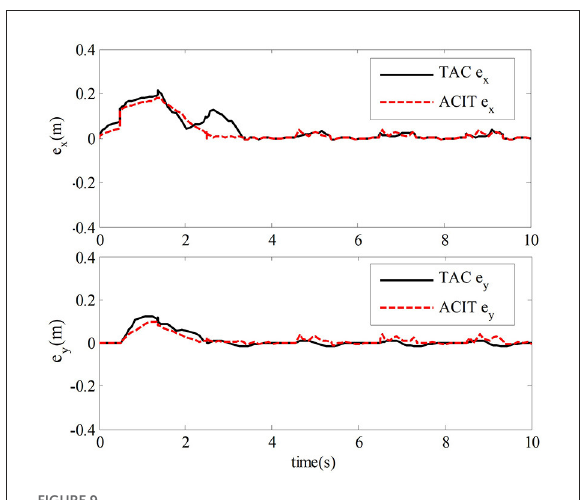
FIGURE9 Position tracking error comparison of master-slave